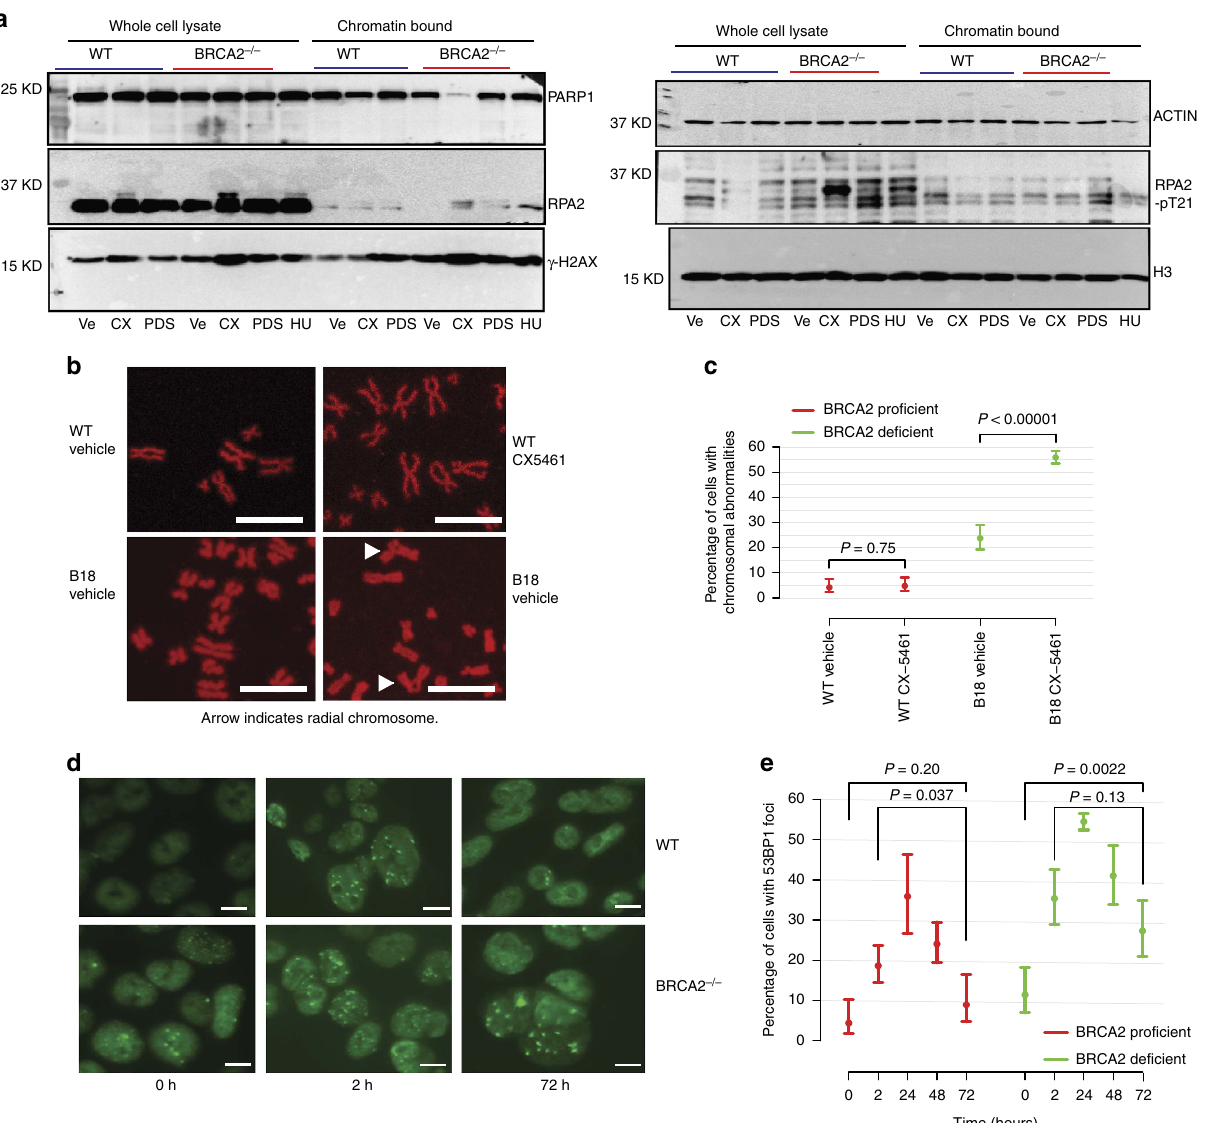
Figure 4 | The repair of CX-5461 and CX-3543 induced DNA damage relies on BRCA pathway. ( a ) CX-5461 induces higher levels of DNA damage in BRCA2 (cid:2) / (cid:2) cells as manifested by the increase of g -H2AX and RPA phosphorylation in BRCA2 (cid:2) / (cid:2) cells. HCT116 BRCA2 þ / þ and BRCA2 (cid:2) / (cid:2) cells were incubated with vehicle (Ve), 10 m M CX-5461 (CX) or 10uM PDS for 4h after 1h release from double thymidine block. Whole-cell lysates or chromatin bound fractions were analysed by Western blotting. BRCA2 þ / þ cells treated with 2mM HU for 4h were immunoblotted as a control. Increased g -H2AX and RPA phosphorylation happened before apoptosis as shown by the absence of Parp1 degradation. Uncropped western blotting pictures are shown in Supplementary Fig. 11. ( b ) BRCA2 (cid:2) / (cid:2) HCT116 cells accumulate more chromosome abnormalities in the presence of CX-5461 (10 (cid:2) 8 M 48h) demonstrated by mitotic chromosome spread. Scale bar, 10 m M. Arrows point to chromosome structure abnormalities. ( c ) Percentage of cells with chromosome abnormalities with experimental conditions stated in b . N Z 3, 4 50 cells each replica. 95% CIs are shown for each data point. ( d ) 53BP foci after pulse CX-5461 treatment were resolved in WT HCT116 cells after 72h but not in BRCA2 (cid:2) / (cid:2) HCT116 cells. Cells were pulse treated with CX-5461 at 10 (cid:2) 8 M for 2h, and then the drug was washed out. Damage foci were monitored after 24, 48 and 72h. Scale bar, 10 m M. ( e ) Plot displays the percentage of HCT116 cells with 53BP1 foci with experimental conditions stated in d . At least three independent experiments were done ( 4 100 cells were counted each time). P values were calculated using two-tailed randomization